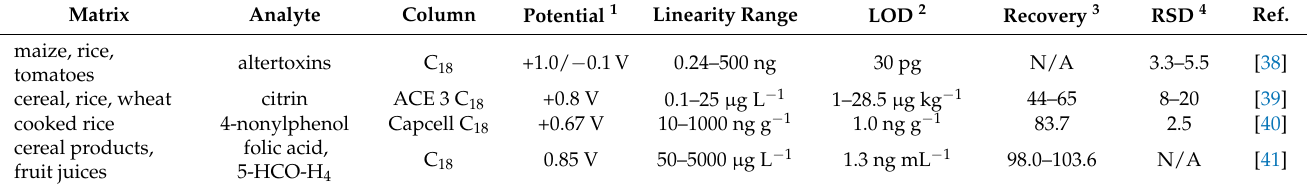
Table 1. HPLC-ED analysis performance in the analysis of different compounds in cereal, rice and wheat matrices. The term “N/A” means the information is absent in the